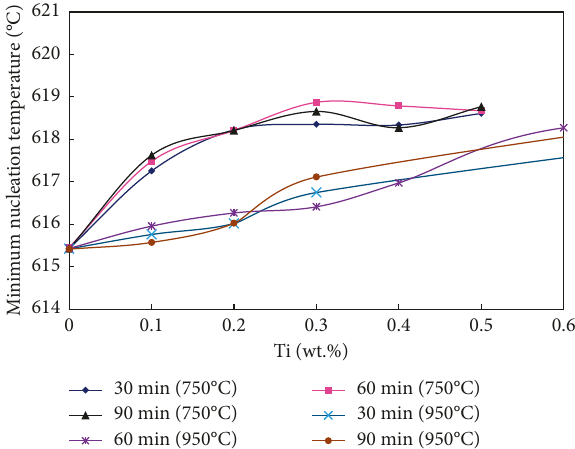
Figure 9: Variation in the nucleation temperature as a function of Ti content and melting conditions.